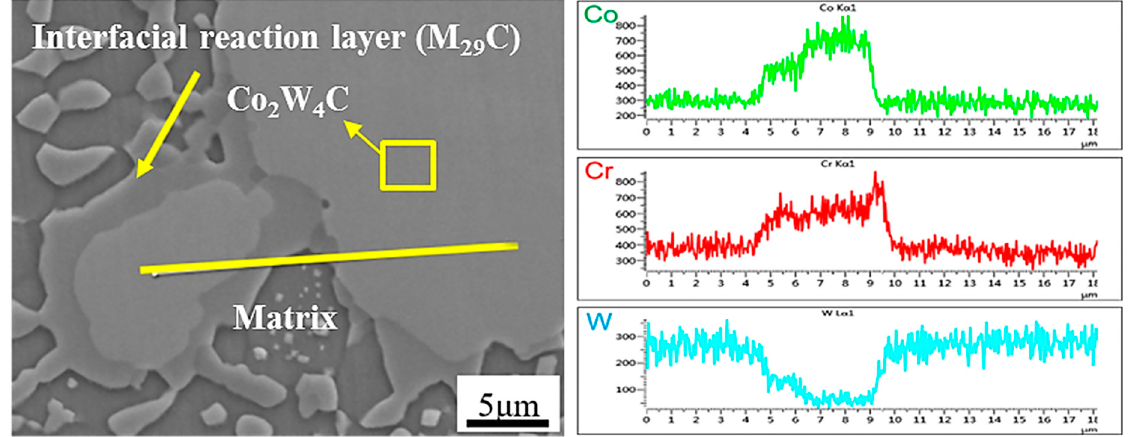
Figure 9. EDS line-scan result from the Co 2 W 4 C to the matrix in the Co–Cr–W matrix composites.